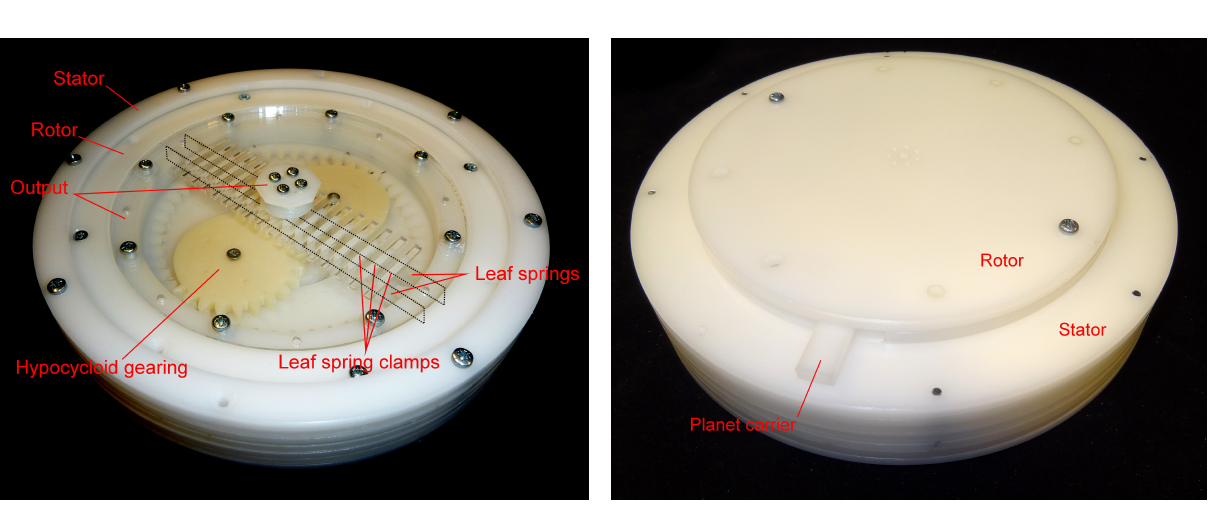
Figure 1. The novel variable stiffness mechanism creates compliance between the rotor and output by means of leaf springs, and it is made variable by means of support pins that can be moved in between the leaf springs by using a hypocycloid gearing